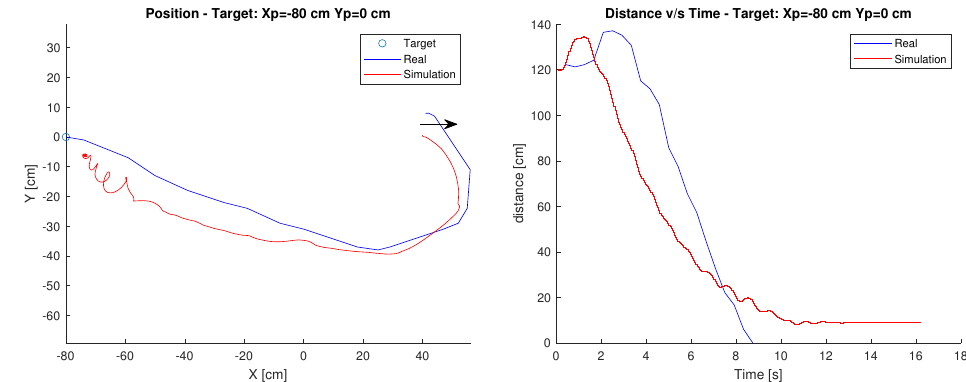
Figure 11. Position and distance to target X p = − 80 cm, Y p = 0 cm with the RL controller.